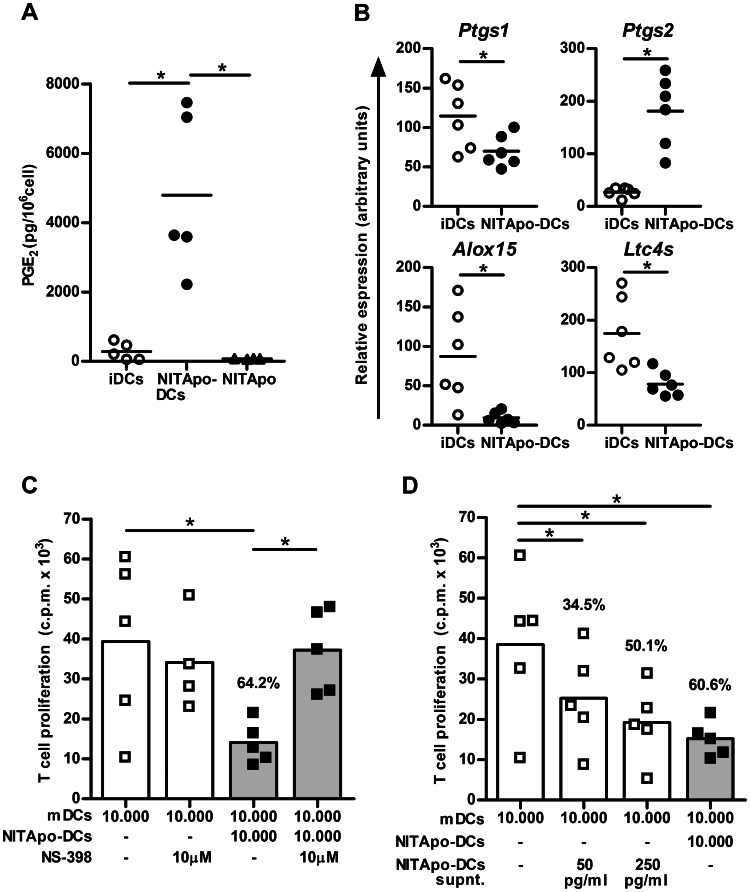
Effect of prostaglandin E2 produced by NITApo-DCs on T cell proliferation.
A) Quantification of the PGE2 by ELISA in culture supernatants of immature DCs (iDCs, white circles), DCs loaded with apoptotic cells (NITApo-DCs, black circles) and apoptotic NIT-1 cells (NITApo, black triangles). ELISA data are represented as pg/106 cells. Plots show the mean (line) of five independent experiments. B) Quantitative RT-PCR results for Ptgs1, Ptgs2, Alox15 and Ltc4s genes in iDCs (white circles) and in NITApo-DCs (black circles). Gene expression signals were normalized to gapdh. Plots show the mean (line) of six independent experiments. C) Autologous T cell proliferation (c.p.m. for 3H thymidine assay) induced by mDCs (white bars) in the presence of NITApo-DC (grey bars) with insulin (20 µg/ml) at a ratio of 1∶1 for 7 days. NS-398, specific-COX2 inhibitor (10 µM) was added to block PGE2 production and reverse the suppressive effect of NITApo-DCs. Percentage of inhibition is given on top of histogram bar. Results from five independent experiments. D) Autologous T cell proliferation (c.p.m. for 3H thymidine assay) induced by mDCs (white bar) in the presence of NITApo-DC (grey bar) with insulin (20 µg/ml) at a ratio of 1∶1 for 7 days. To determine if the mechanism depends on cell-cell contact, supernatants from NITApo-DCs cultures, (white bars, 50 and 250 pg/ml of PGE2) were added to suppression assays instead of NITApo-DCs. Percentage of inhibition is given on top of histogram bars. Results from five independent experiments (Mean). Bars and symbols represent mean and individual experiments, respectively. One-sided Wilcoxon test was used for the evaluation of statistical significance. Symbol * marks statistically significant differences, p<0.05.